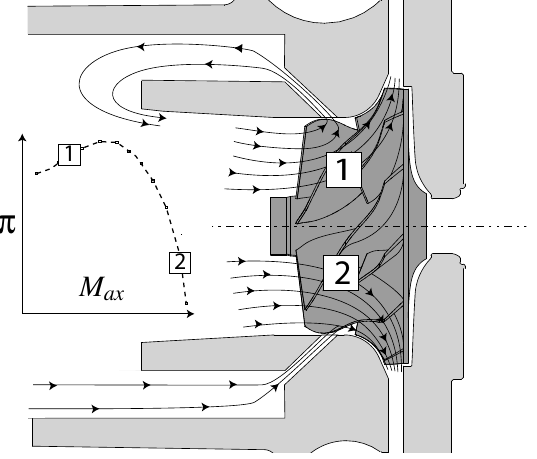
Figure 3. Working principle and schematic visualization of an inducer recirculation bypass for centrifugal